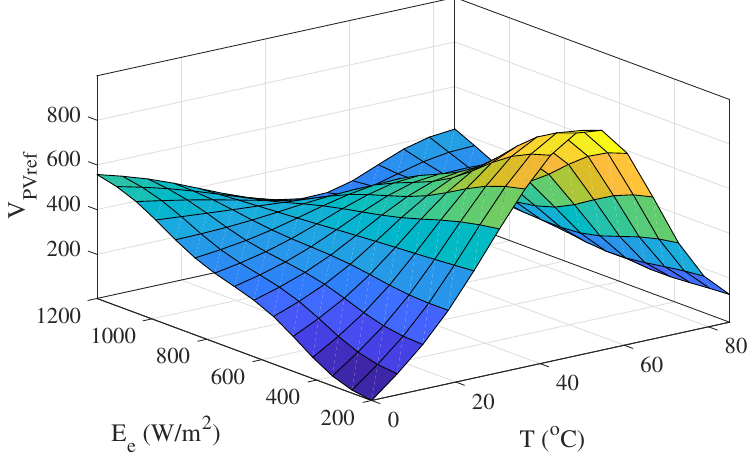
Figure 3. 3D-plane ( V PVref , T , E e ).